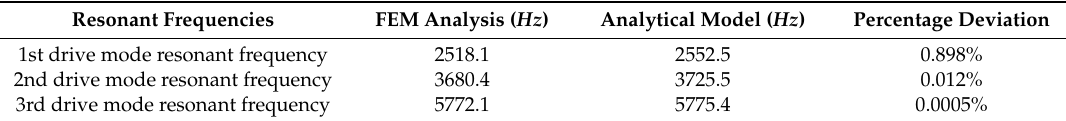
Table 3. Comparison of the analytical and FEM-based modal analysis results.